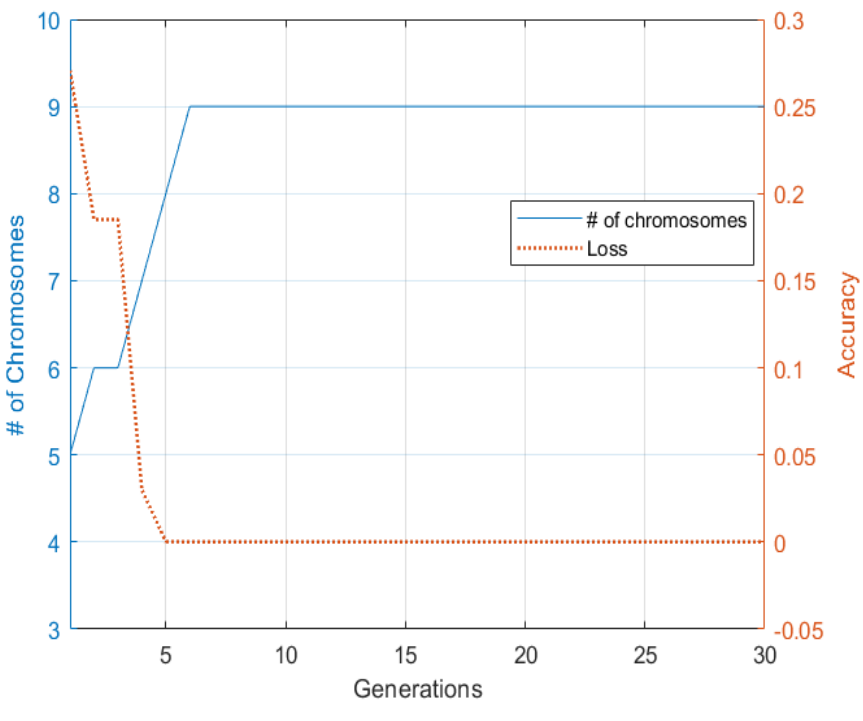
Figure 5. Final architecture of experiment.